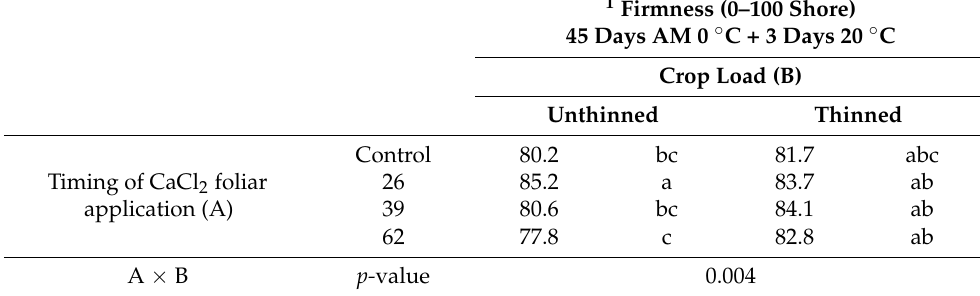
Table 10. Effect of the timing of foliar CaCl 2 application (i.e., Control, and 26, 39, or 62 days after full bloom, DAFB) and crop load (natural crop load without fruit thinning vs. 50% of fruit removal 31 DAFB) on fruit firmness under cold storage (45 d at 0 ◦ C in modified atmosphere packaging) in the sweet cherry combination